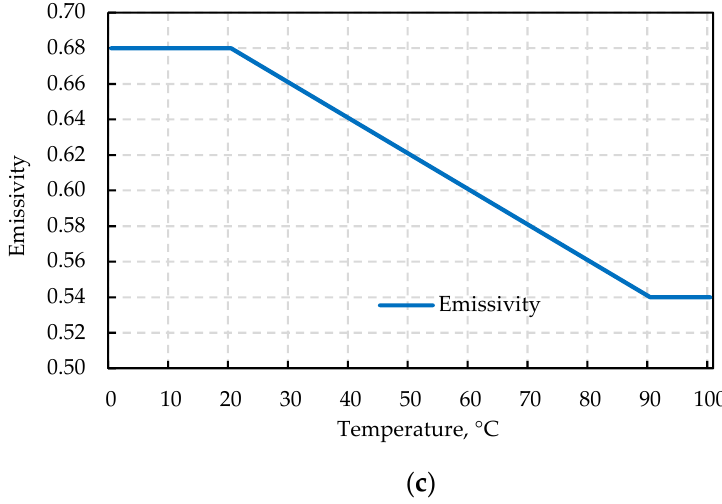
Figure 7. Optical properties of the thermochromic windows [17].